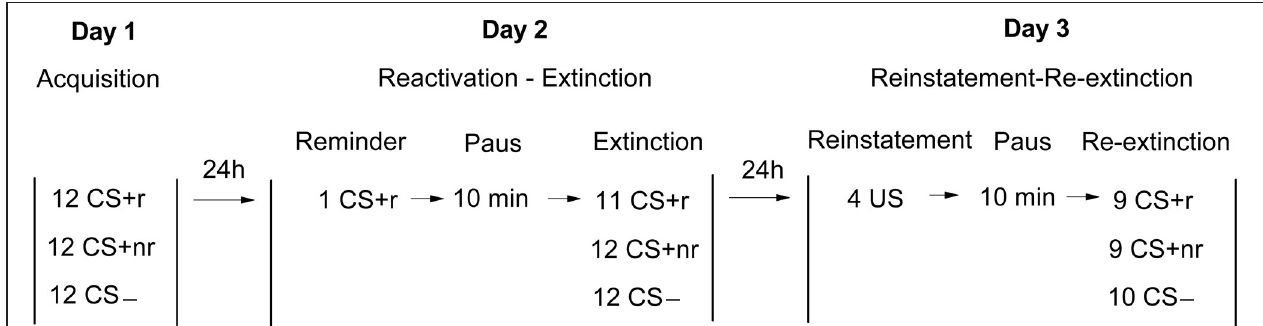
FIGURE 1 | Experimental design. Acquisition, Extinction, and Reinstatement testing occurred on three consecutive days. On day 1, subject were fear conditioned to two different CSs (CS + r, CS + nr) that were followed by an electrical shock on 50% of the presentations whereas a control stimulus (CS − ) was never followed by the shock (Acquisition). On day 2, subjects received one single reminder trial of the CS + r